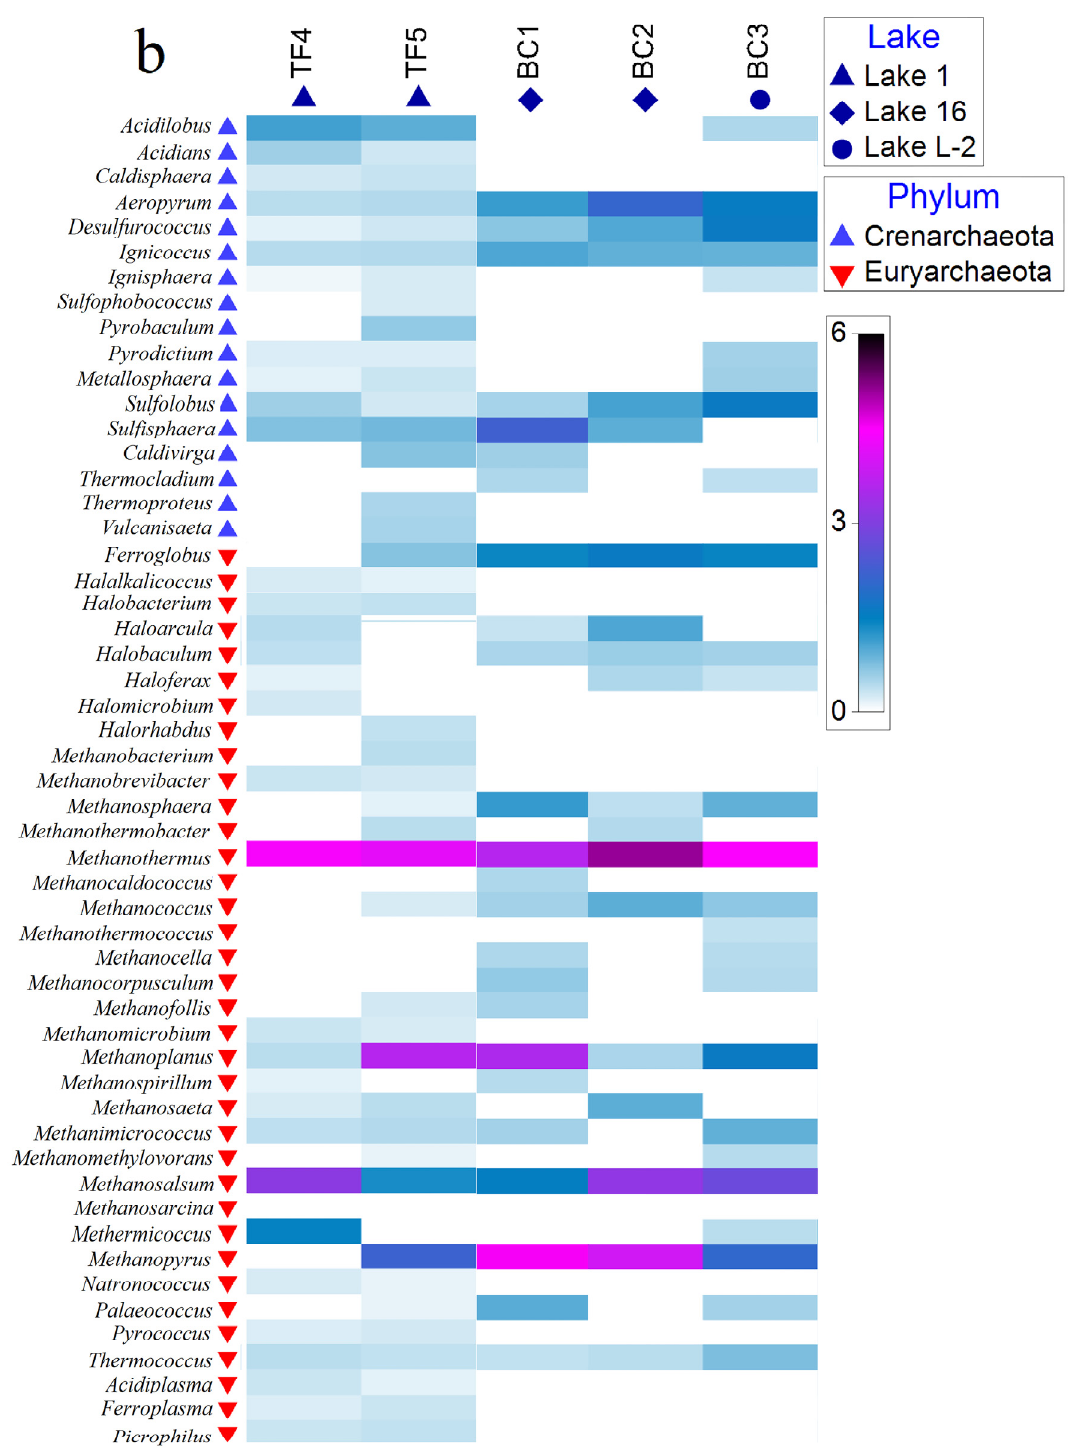
Figure 4. Shade matrix plots showing ( a ) the bacterial community structure at the genus level and ( b ) the archaeal com- munity structure at the genus level. Shading intensity within the matrix indicates the square root transformed relative abundance of each genus.